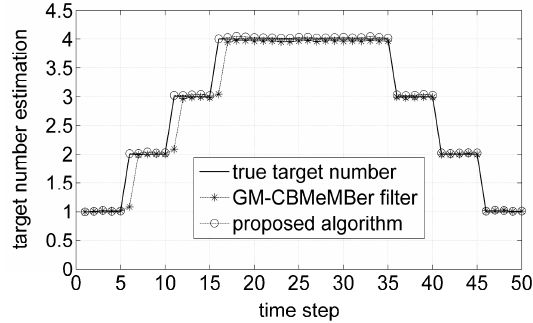
Figure 2. Average target number estimations for different algorithms.